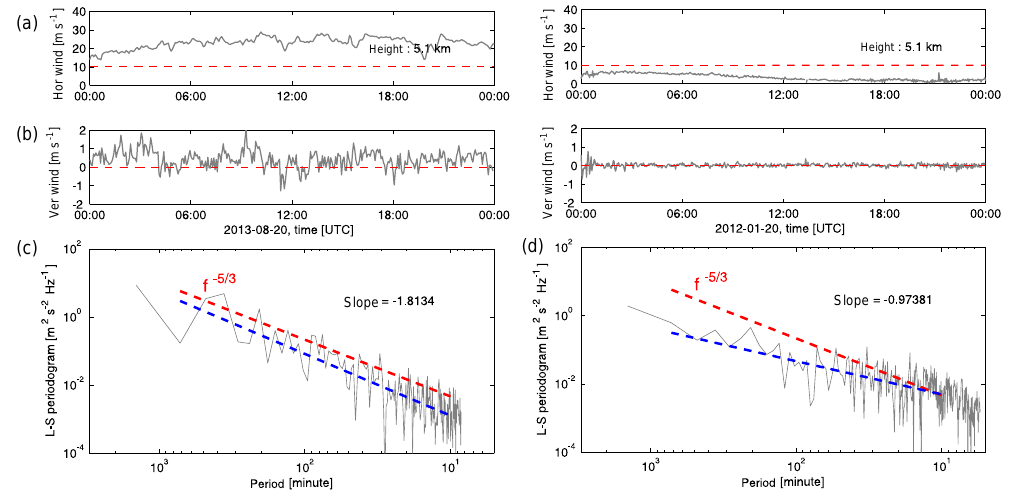
Figure 5. Power spectra of vertical wind velocity versus period (or frequency) using Lomb–Scargle periodogram during active (c) and quiet periods (d) . Horizontal and vertical winds are plotted in (a) and (b) , respectively. The lines of horizonal winds = 10ms − 1 and vertical winds = 0ms − 1 are also shown in red as reference. Note that the frequency cutoffs depend on the time resolution of the analyzed data set (2–5min for the current study).